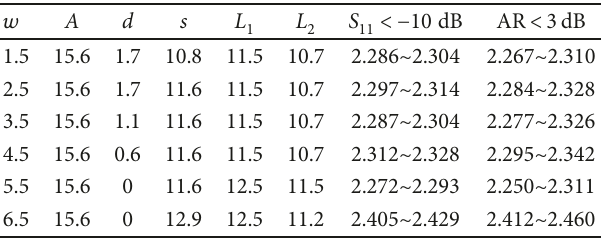
Figure 6: Simulated results of the proposed antenna with di ff erent lengths L 1 : re fl ection coe ffi cient and AR. Table 2: Optimal design parameters and performance of the CP antenna with di ff erent stub widths.